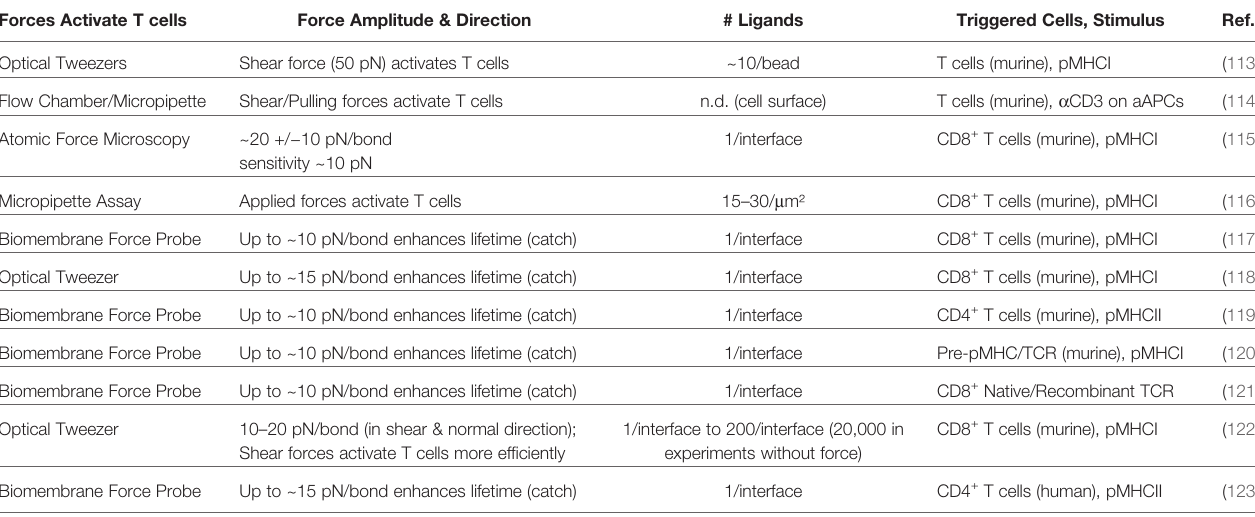
TABLE 1 | Overview of published articles investigating the impact of mechanical forces on T-cell activation. Forces Activate T